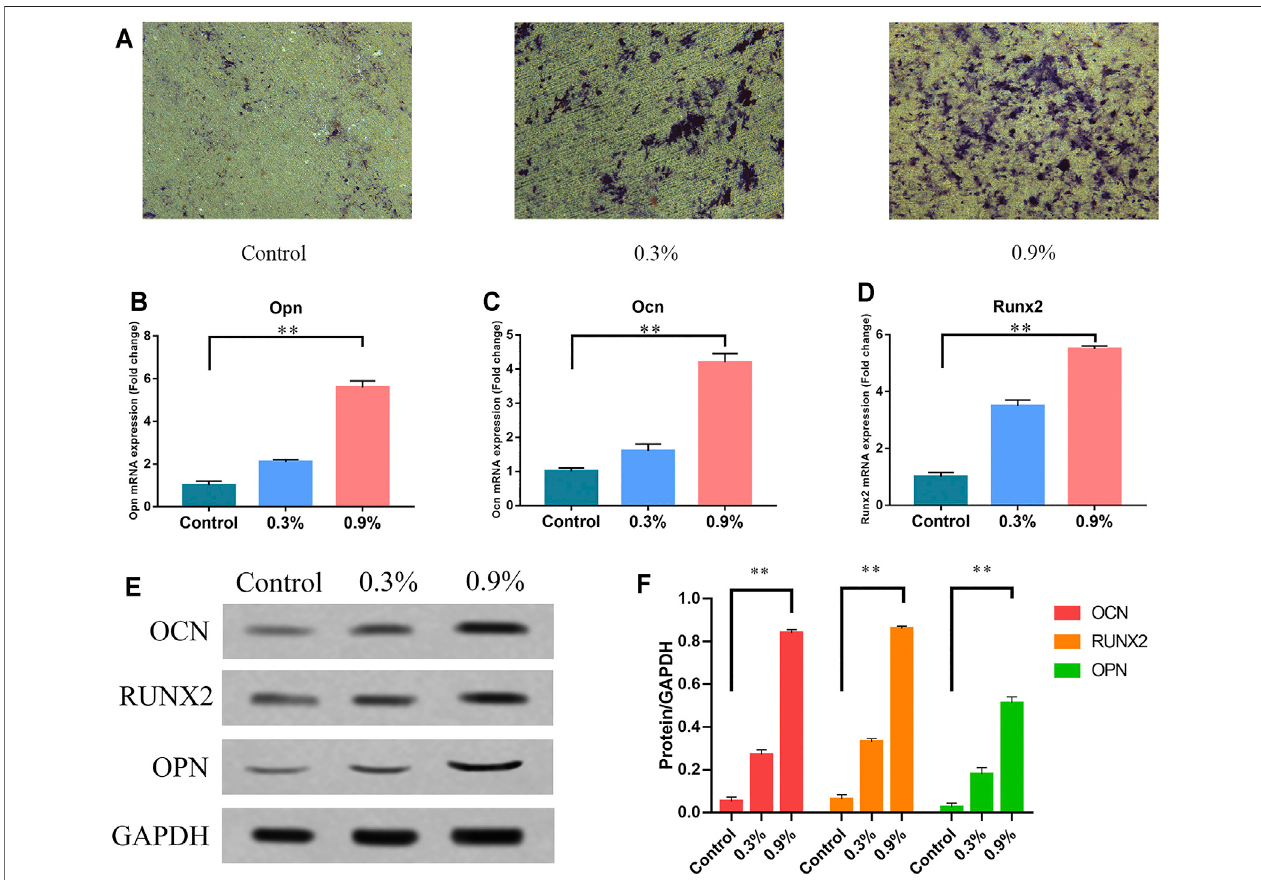
FIGURE 2 | Cyclic mechanical strain can promote osteogenic differentiation of BMSCs. (A) ALP activity of BMSCs after 7 days of treatment. Scale bars: 500 μ m. (B – D) The mRNA expression of Opn, Ocn, and Runx2 in BMSCs after 7 days of treatment. RT-qPCR data are presented as mean ± SD normalized against the control group data. The housekeeping gene GAPDH was used as an internal control. (E) Western blots of Opn, Ocn, and Runx2 after 7 days of treatment. GAPDH is shown as the loading control. (F) Semi-quantitative and statistical analysis of the results in Panel E. Values are plotted as mean ± SD, * p < 0.05, ** p <